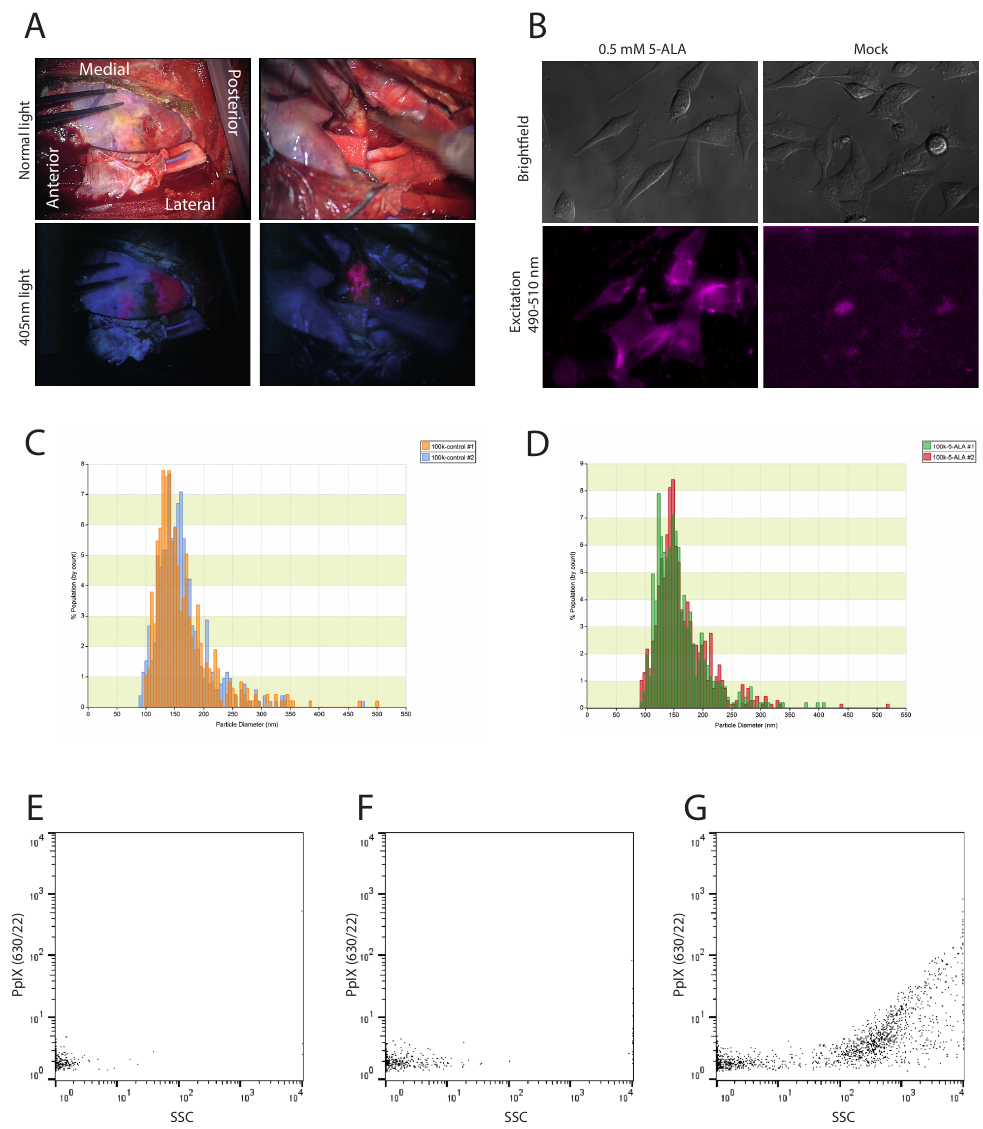
Figure 1. Administration of 5-ALA leads to PpIX fluorescence in vitro and in vivo. ( A ) Intra-operative view of Glioblastoma resection under white light (top row) and under 405nm light (bottom row). Protoporphyrin IX (PpIX) fluorescence is seen as pink. ( B ) U87 cells treated with 5-aminovulenic acid (5-ALA) (left panels) show PpIX fluorescence upon excitation at 490nm compared to control (right panels). 40 × magnification. ( C ) Tunable resistive pulse sensing (TRPS) analysis of EVs isolated from U87 cells treated with 5-ALA. n = 2 ( D ) TRPS analysis of EVs isolated from U87 cells treated with PBS control. n = 2. ( E ) High-resolution flow cytometry (hFC) analysis of PBS. ( F ) hFC analysis of PBS with EVs isolated from U87 cells. ( G ) hFC analysis of PBS with EVs isolated from U87 cells treated with